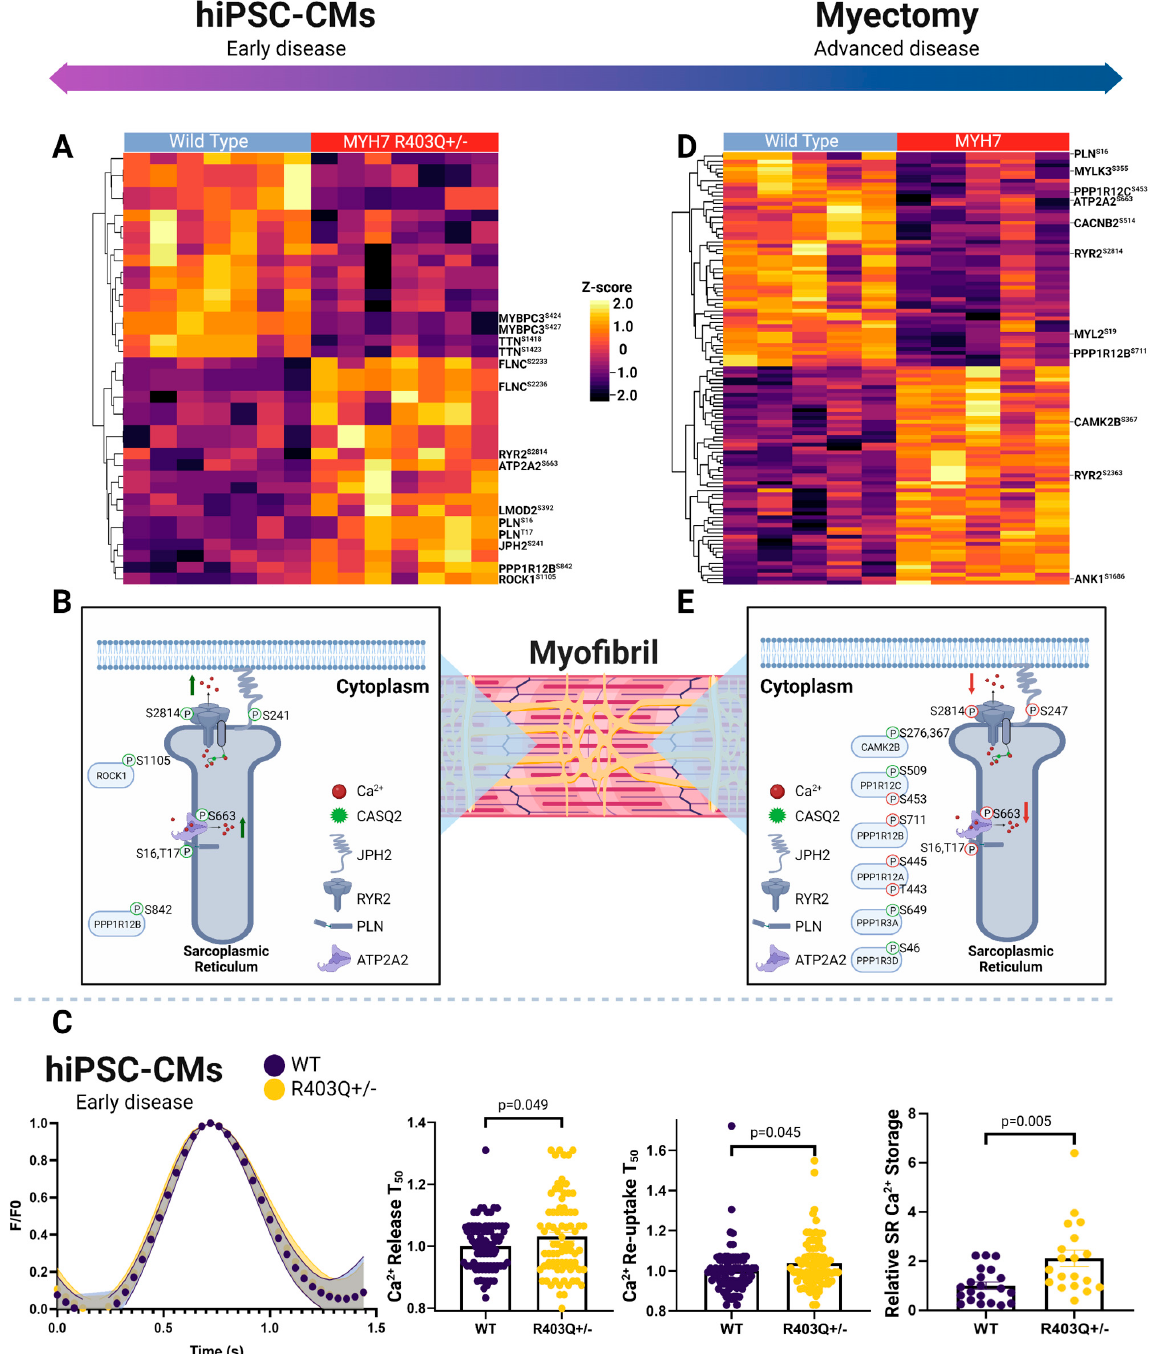
Figure 5. Phosphoproteomic landscape of excitation contraction coupling proteins. ( A ) Hierarchical clustering (Euclidean distance) showing changes in phosphosite abundance of significantly differ- entially phosphorylated proteins linked to excitation contraction coupling in hiPSC-CMs and ( B ) patient myectomy samples. ( C ) Schematic depiction of select SR phosphoproteins in hiPSC-CMs and ( D ) clinical specimens. ( E ) Plots showing average Ca 2+ transients (N = 3; n > 75 cells) normalized to WT transient, with error bands representing SEM (left), relative time for Ca 2+ release into and reuptake from the cytoplasm compared to average WT cell (N = 3; n > 83 cells) (middle), and relative